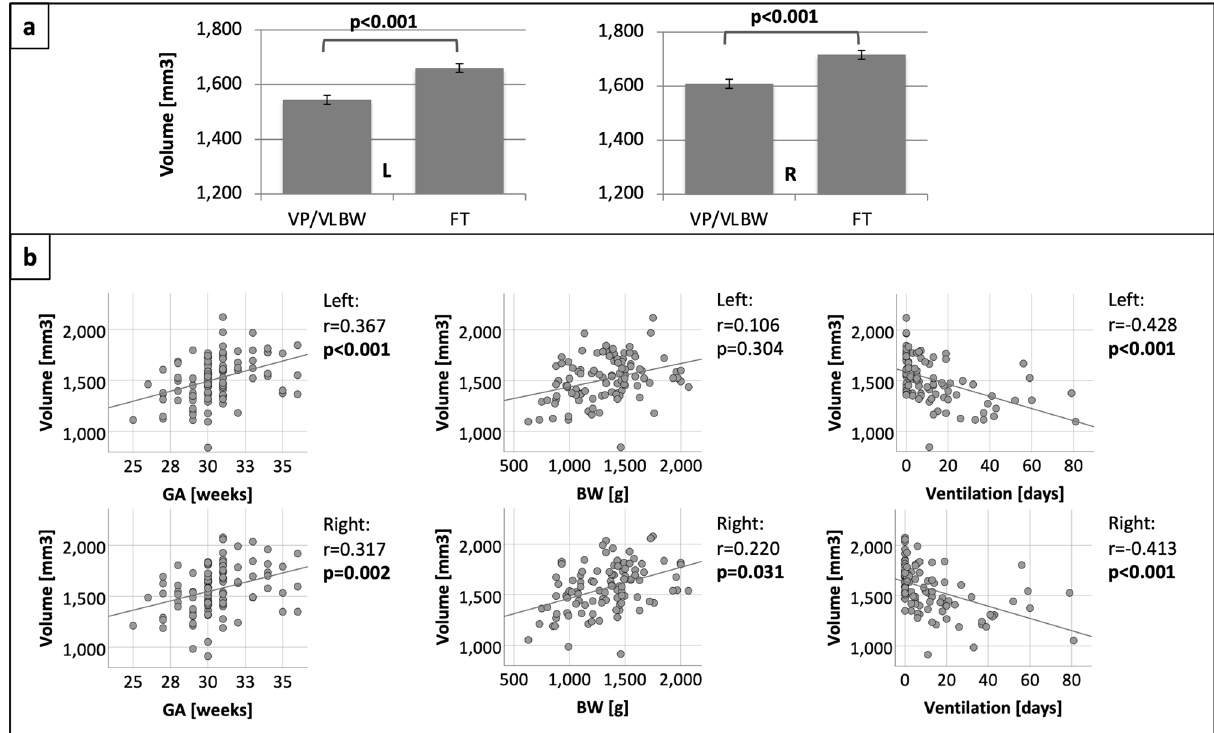
Figure 2. ( A ) Group comparison of whole amygdala volumes. Estimated marginal means of left and right whole amygdala volumes (in mm 3 ) are shown as bar charts with SE (in mm 3 ) as error bars. Bold letters indicate statistical significance. ( B ) Relationship between whole amygdala volume and variables of premature birth. The associations between left and right whole amygdala volume and GA, BW and duration of ventilation are shown as scatter plots. GA (in weeks), BW (in grams) and duration of ventilation (in days) are plotted on the x-axes. Whole amygdala volumes (in mm 3 ) are plotted on the y-axes. Linear regression lines as well as correlation coefficients and p -values were added. Bold letters indicate statistical significance after FDR correction using the Benjamini–Hochberg procedure. Abbreviations: BW, birth weight; FT, full term; GA, gestational age; L, left; n. s., not significant; R, right; VP/VLWB, very preterm and/or very low birth